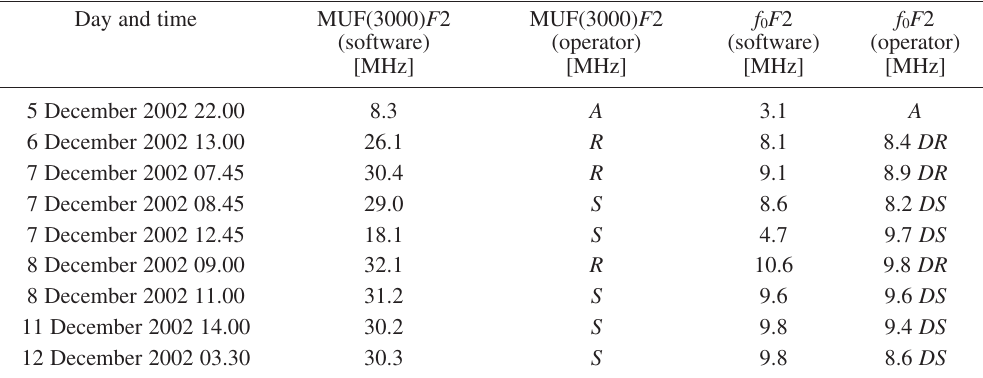
Table II. The few cases (9 out of 1124, equal to 0.8%) in which the program scales values but the operator is not able to read a value. A comparison between the output of Autoscala and the corresponding manual scaling performed by a very experienced operator according to the standard URSI is